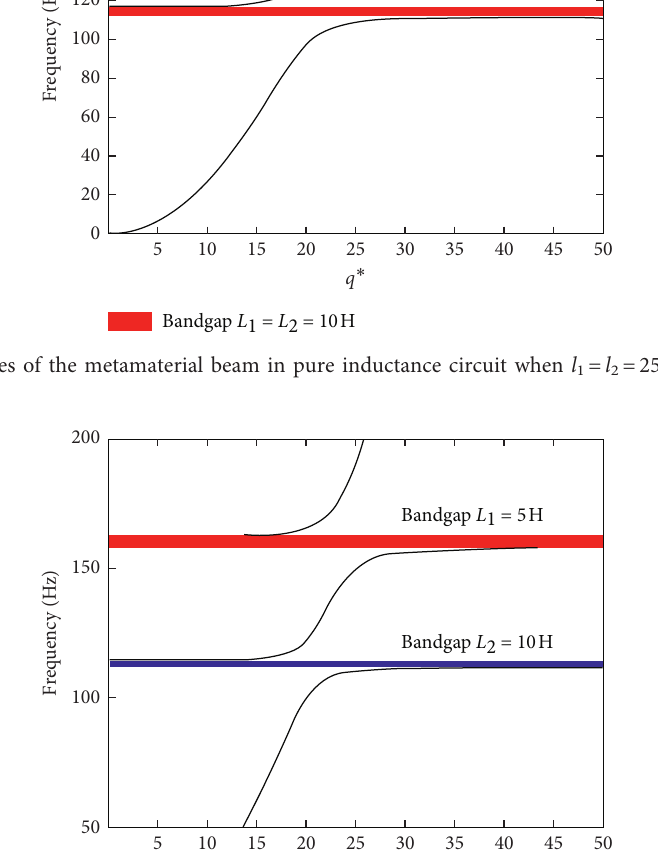
� 5 H and L � 10H. 1 2